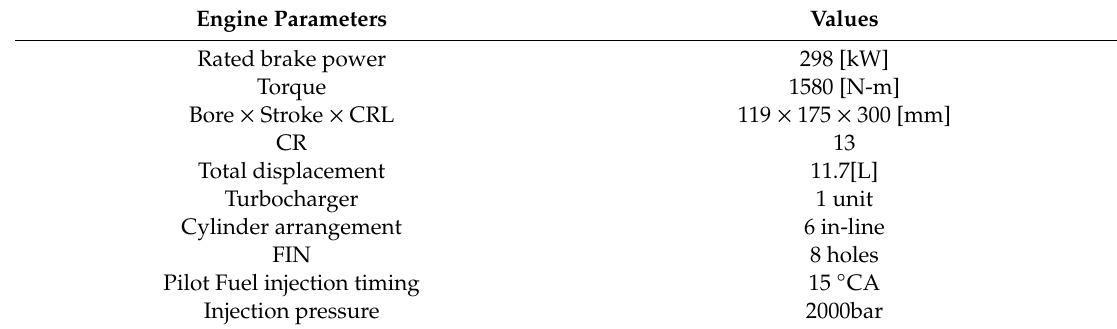
Figure 3. Engine setup. Table 2. Engine